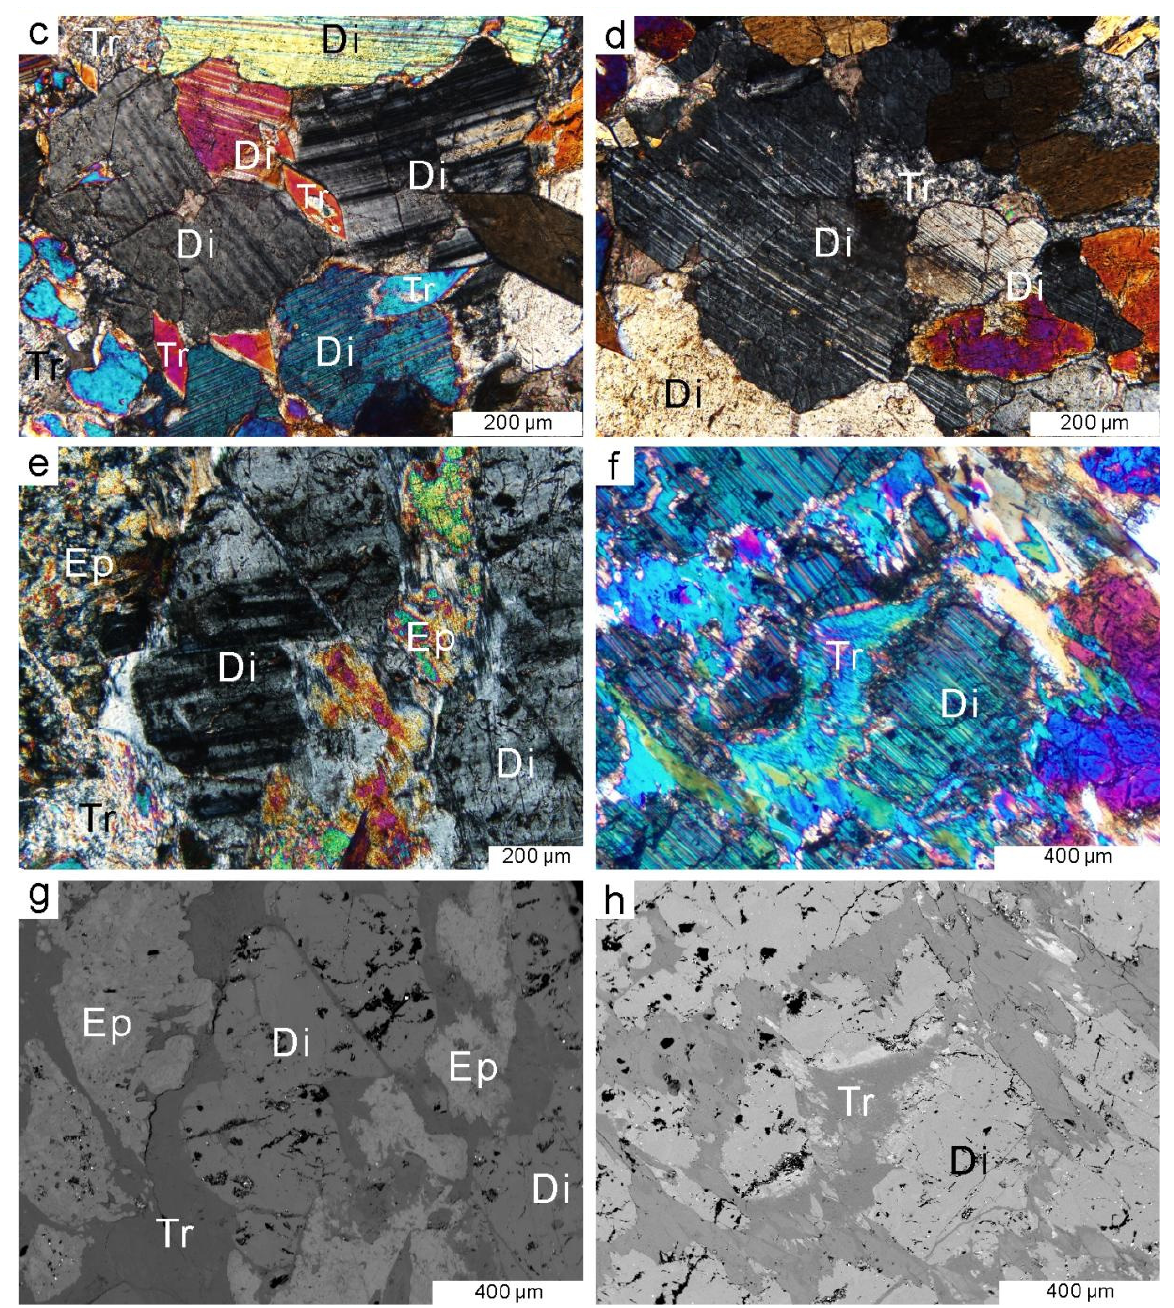
Figure 3. Micropetrography photos ( a – f ) and BSE images ( g , h ): ( a ) Twinned diopsides very close to nephrite from the sample in Figure 2c; ( b ) Optical indicatrix determination involving the insertion of a gypsum plate, the twinning planes are parallel to the Nm optical axis; ( c – f ) Twinned diopsides in the contact zone from Tatliksu exhibit alternations of bright and dark bands. Some twin lamellae and nearby tremolite fibers are curved; ( g , h ) the same domain in ( e ) and ( f ), respectively. Each individual diopside twin displays identical brightness in BSE images, showing no obvious chemical change. Di—diopside; Ep—epidote; Tr—tremolite; Ng, Nm and Np—optical axis, Ng > Nm > Np; O.A.P—optical axial